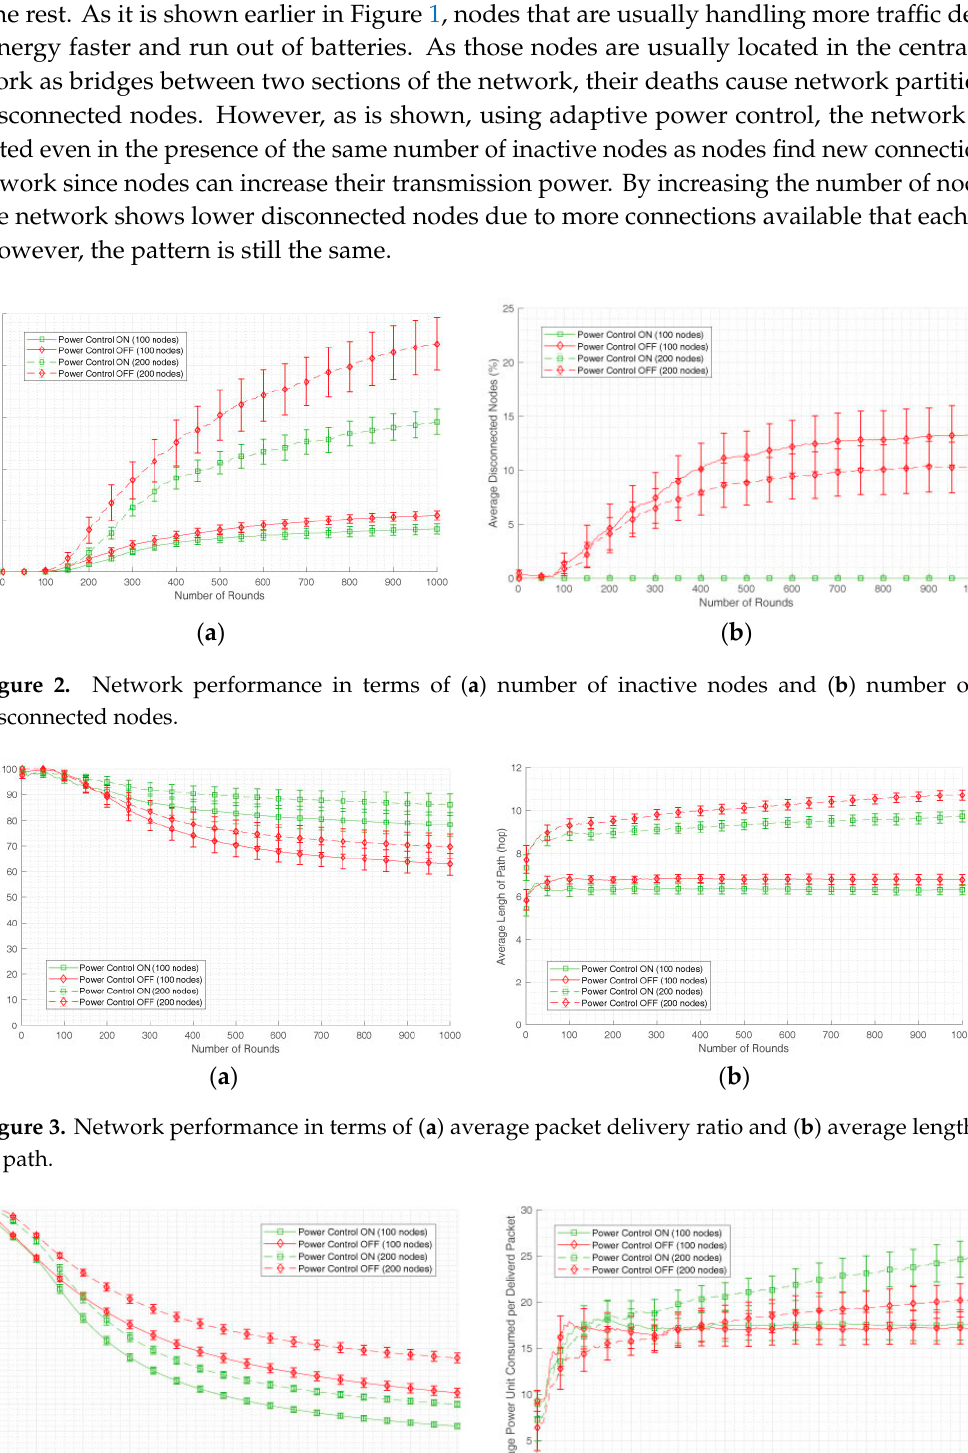
Figure 3. Network performance in terms of ( a ) average packet delivery ratio and ( b ) average length of path.